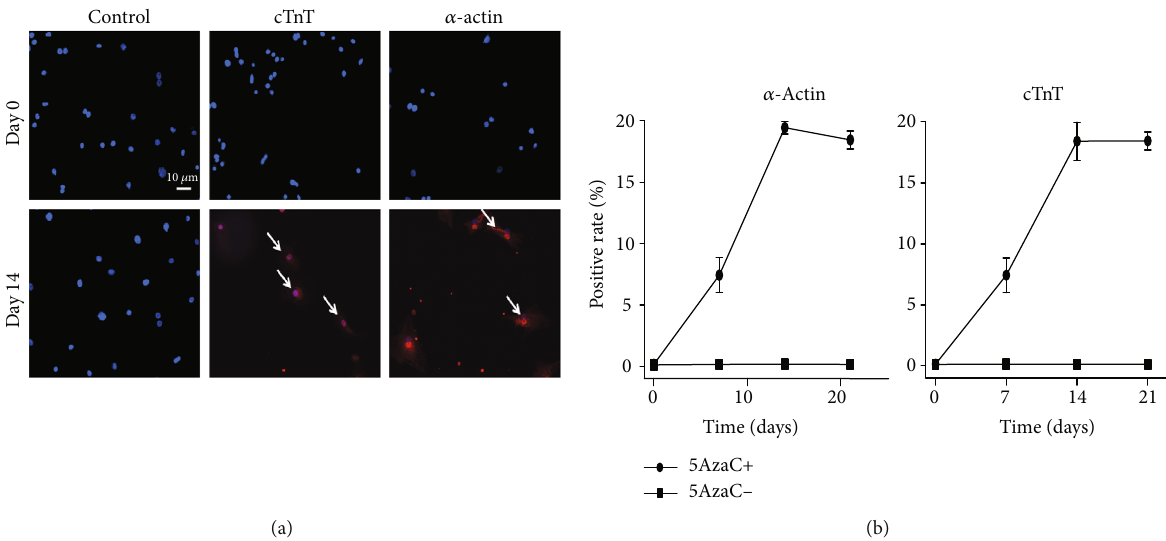
Figure 4: 5-AzaC treatment increased levels of cardiac troponin-T (cTnT) and α -sarcomeric actin ( α -actin) in BM-VSELs. (a) Immunostaining for cTnT and α -actin in cardiomyocytes derived from 5-AzaC-induced di ff erentiation of VSELs. The white arrow indicates positive cells. (b) Flow cytometric analysis demonstrated the percentages of cTnT- and α -actin-positive cells on di ff erent days.